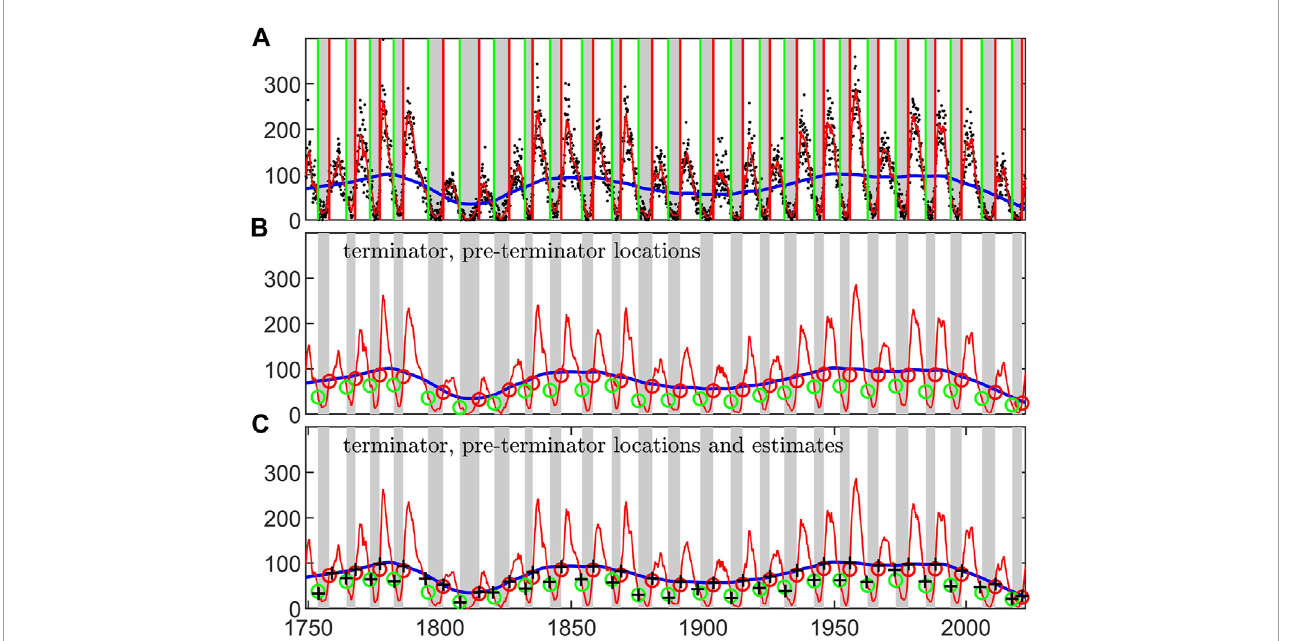
FIGURE 3 Switch-on and switch-off times overplotted on the monthly sunspot record. The 13 month running mean of the monthly sunspot number (red) and its 40 year (lowess) slow trend (blue) are overplotted on the quiet intervals (grey shading) between each pre-terminator and terminator. (A) also plots the monthly sunspot number (black dots) and vertical lines indicating the pre-terminators (green) and terminators (red) at the start and end of each quiet interval. (B) overplots circles on the 13 month running mean of the monthly SSN when the pre-terminators (green circles) and terminators (red circles) occur, that is, when the analytic phase is at − 4 π / 5 and zero respectively. (C) is the same as (B) except that it also overplots (black crosses) estimates of the pre-terminators and terminators based solely on the monthly sunspot record; these are at the value of the 13 month smoothed SSN 12 month after the SSN down-crosses the slow trend (for the pre-terminators) and at the time when the SSN up-crosses the slow trend (for the terminators).